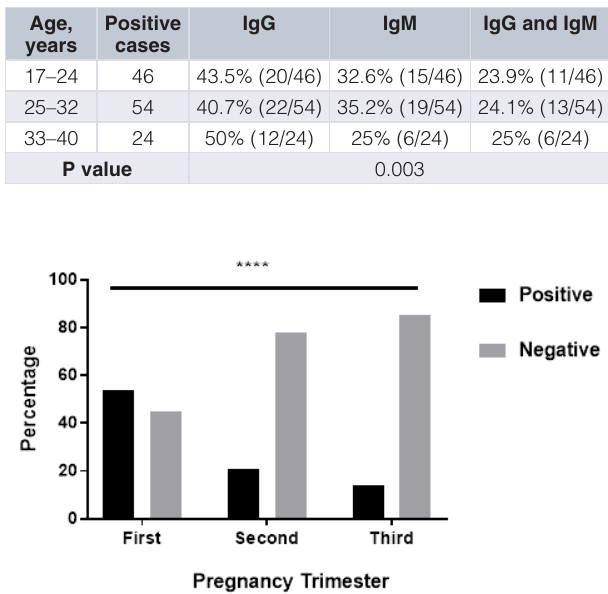
Figure 3. Percentage of IgM seropositivity among the total of positive cases in each pregnancy trimesters. Among the total of positive cases in every trimester, the seropositivity of IgM revealed statistically significant difference. Out of 46, 51, and 27 toxoplamosis infected cases in a first, second and third trimesters, respectively, 54.34% (25/46) were seropositive to IgM (acute infection) in first trimester, 21.56% (11/51) seropositive to IgM in second trimester, and 14.81% (4/27) seropositive to IgM in third trimester. ****P = 0.0001.